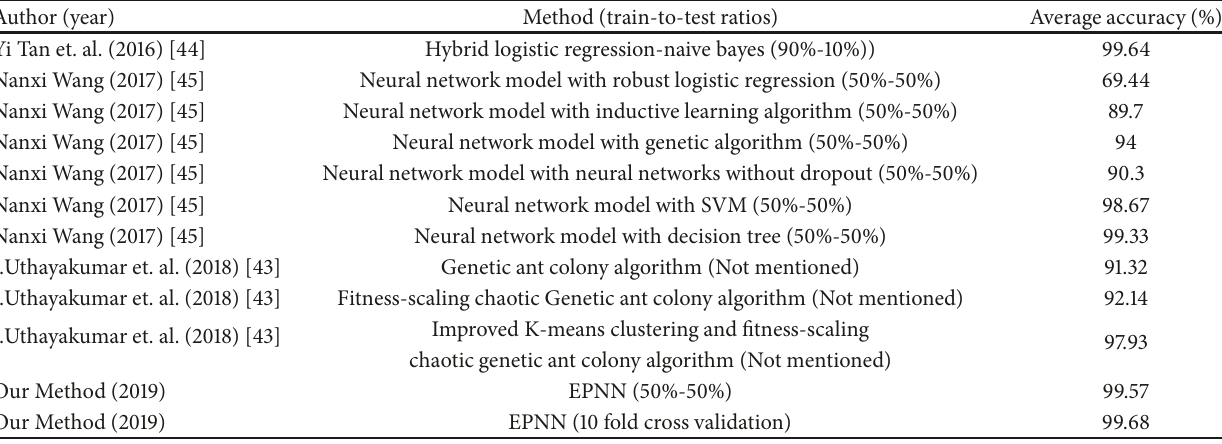
Table 12: Classification accuracies for Qualitative Bankruptcy dataset obtained by other hybrid classification methods in relative literatures.